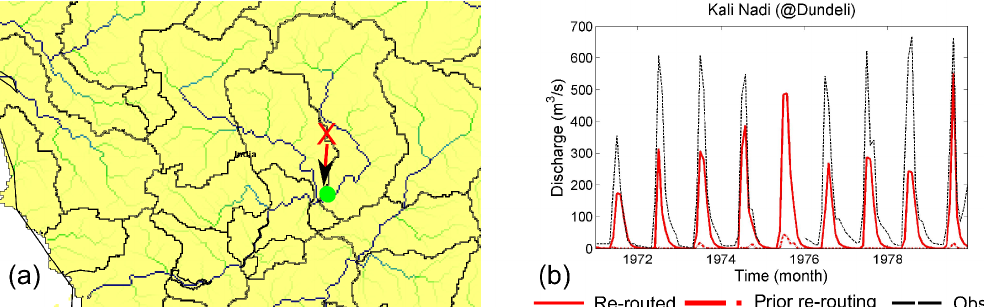
Figure 3. Example of the impact of basin delineation and routing on model behaviour: (a) correction in the location (red x and green circle is prior and after the correction, respectively) of the Dandeli discharge station (Kali Nadi River basin) and (b) the corresponding modelled discharge before and after the correction. In (a) the subbasins and flow accumulation are also depicted.